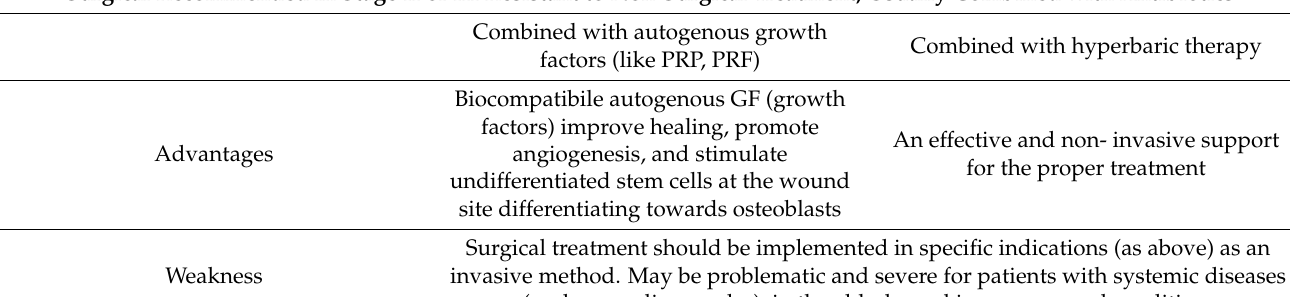
Table 1. Surgical treatment of medication-related osteonecrosis of the jaw (MRONJ). PRF, platelet-rich fibrin; PRP, platelet- rich